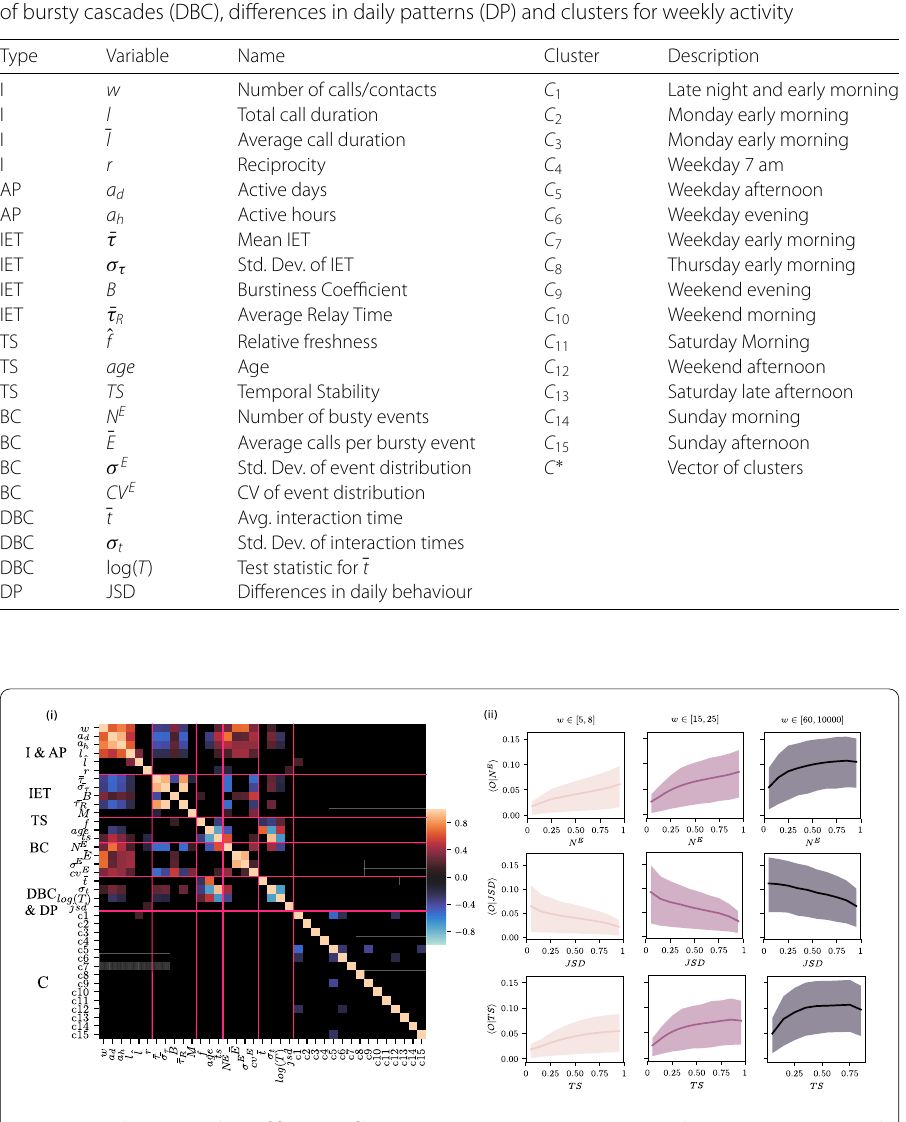
Figure 4 Exploratory analysis of features of human communication: ( i ) Feature correlation matrices measured by Pearson’s correlation coefficient. Features are sorted according to their modelling approach, each case divided by pink lines. Features display high within-group correlations, with lower between-group correlations. Weekly clusters (last group) show no relevant correlations among themselves or to other variables, with